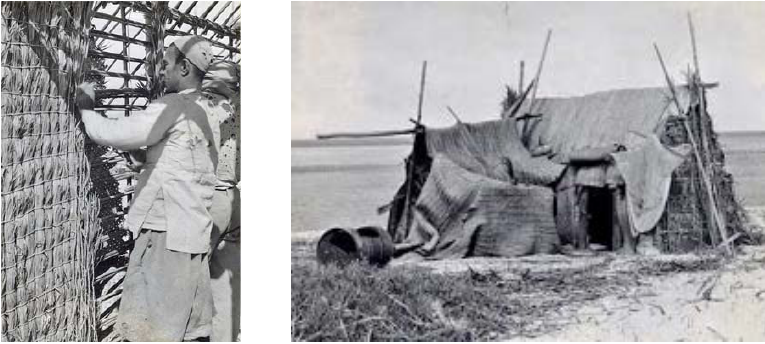
Figure 2. Photographs of palm fronds and leaves house manually made in